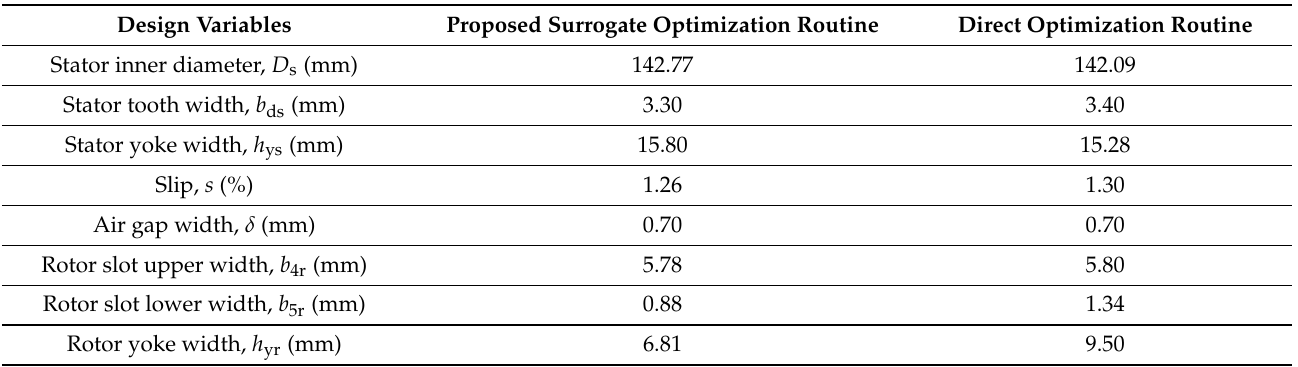
Table 17. Design variables of the optimal solution from the the proposed surrogate optimization routine compared with direct optimization routine.